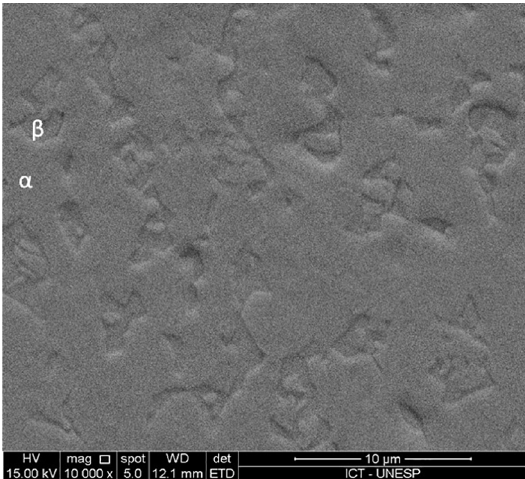
Figure 5 . SEM image of control Ti6Al4V polished sample showing α and β phases.